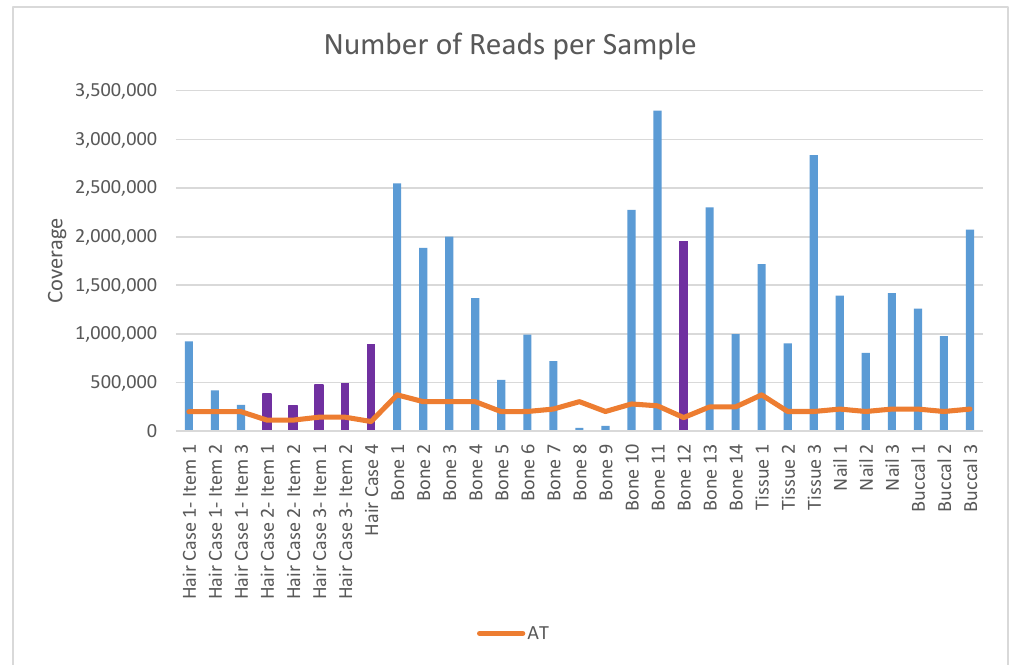
Figure 1. Number of reads per sample and its relation to the analytical threshold (AT). The AT is dynamic in this chart because the samples were not all sequenced in the same run. The AT was determined by multiplying the total usable reads for each run by 0.025 or 0.0125, depending on the number of samples multiplexed in the same run. The value was then plotted on the chart as the orange threshold line. Blue and purple bar distinctions represent samples sequenced in an 8 (blue) or 16 (purple) multiplex.